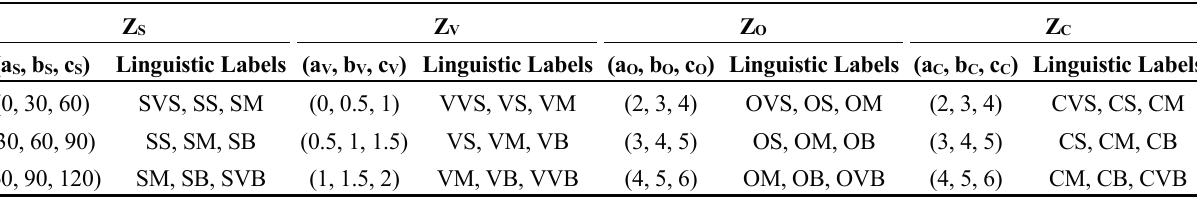
Table 2. Output values and linguistic labels.